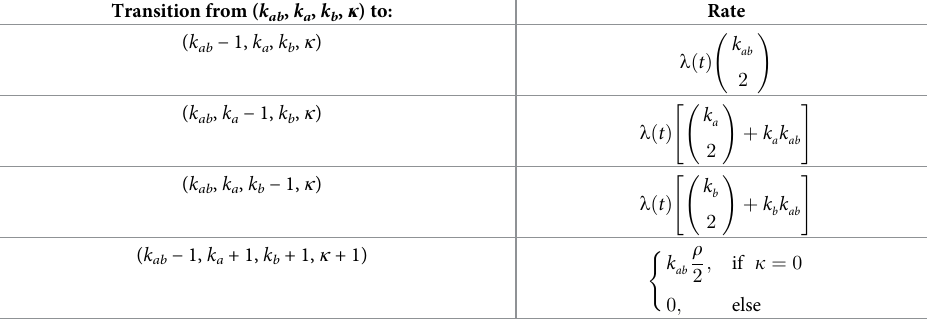
, k , k , κ ) and their respective rates. The ab a b ! k ab l ð t Þ 2 " # ! k a l ð t Þ þ k k a ab 2 " # ! k b l ð t Þ þ k k b ab 2 r ; if k ¼ 0 ab 2 0 ;